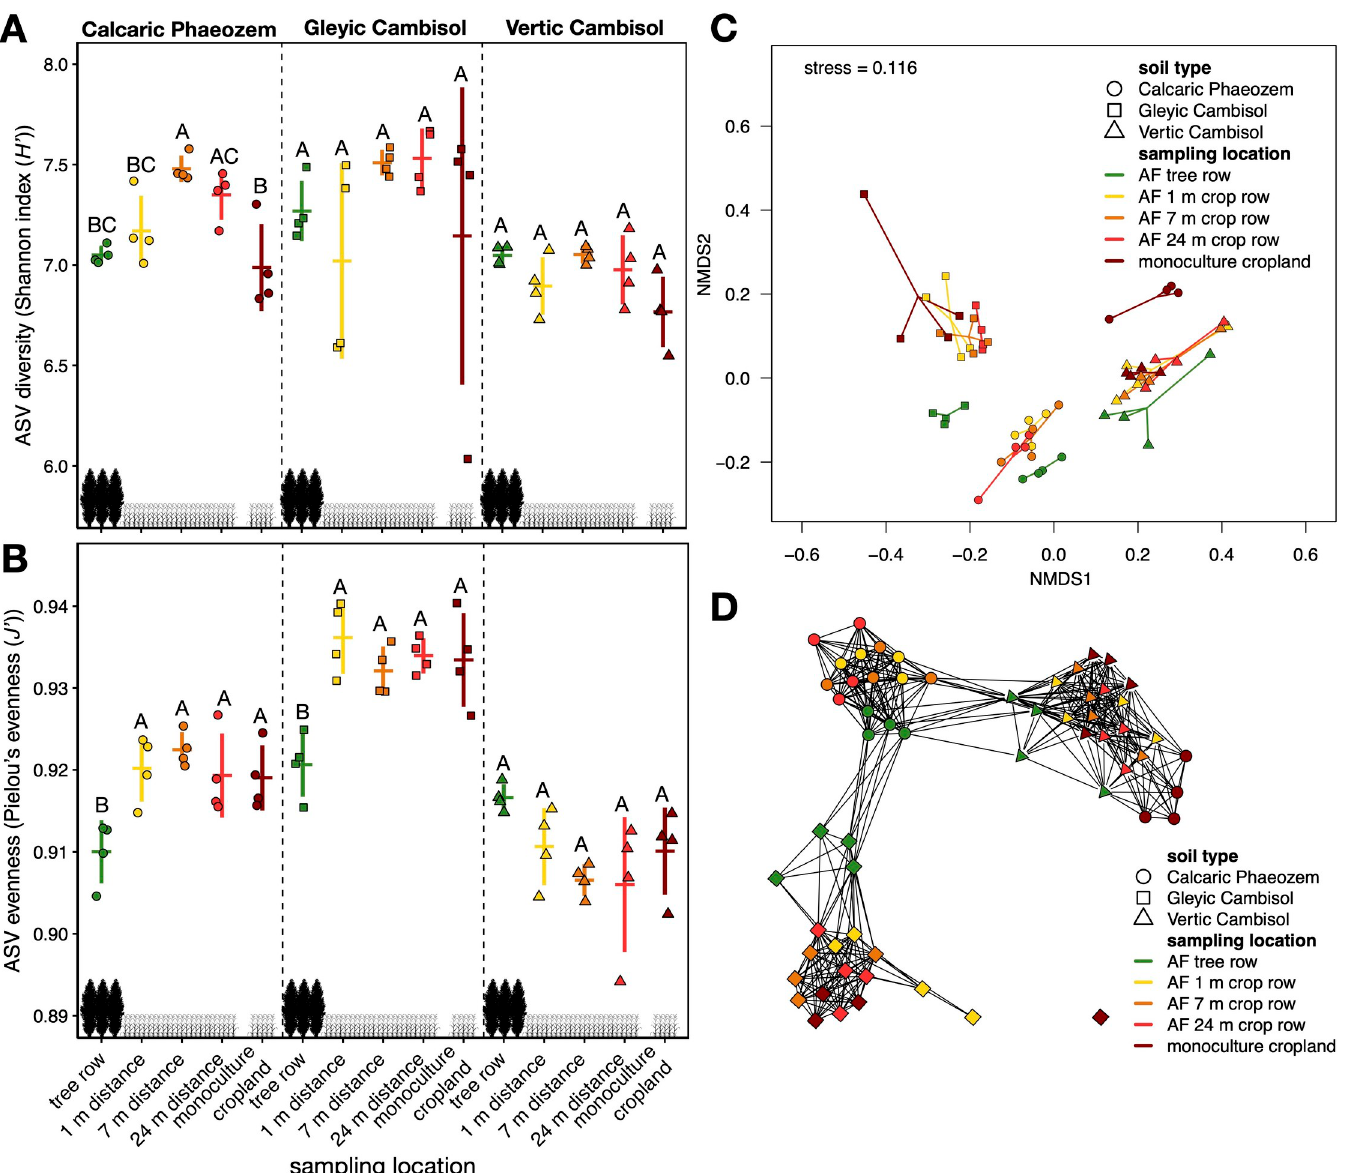
Fig 4. Alpha diversity measures (Shannon index ( H’ ) ( A ) and Pielou’s evenness index ( J’ ) ( B )), non-metric multidimensional scaling (NMDS) of Bray-Curtis dissimilarities ( C ), and Bray-Curtis similarity network ( D ) of soil bacterial ASVs in paired temperate agroforestry and monoculture cropland systems in three different soil types. Samples in the agroforestry systems were collected in the tree row as well as at 1 m, 7 m, and 24 m distance from the tree row within the agroforestry crop row. Coloured vertical bars represent the standard deviation, coloured horizontal bars the mean ( A , B ). Coloured shapes represent individual data points ( A , B ). Different uppercase letters indicate statistically significant differences at p < 0.05 (one-way analysis of variance with Tukey’s honestly significant difference test or Kruskal–Wallis test with multiple comparison extension) ( A , B ). Solid lines in the NMDS span from the centroid of each group to the individual data points ( C ). Edges in the similarity network were drawn between samples with a Bray-Curtis similarity � 0.75 ( D ). The network was spatially arranged applying the Fruchterman-Reingold algorithm ( D ). AF = agroforestry system, ASV = amplicon sequence